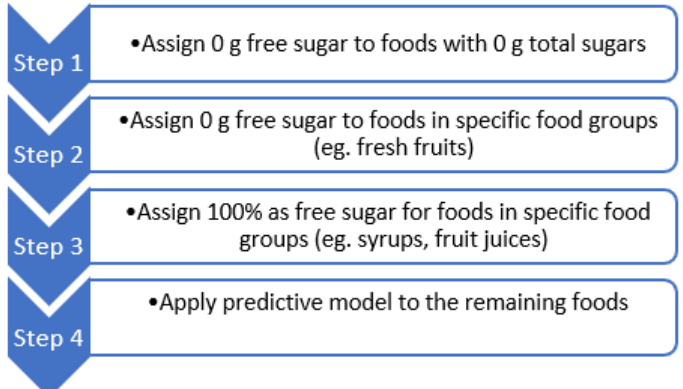
Figure 2. Step-by-step methodology of free sugars imputation .